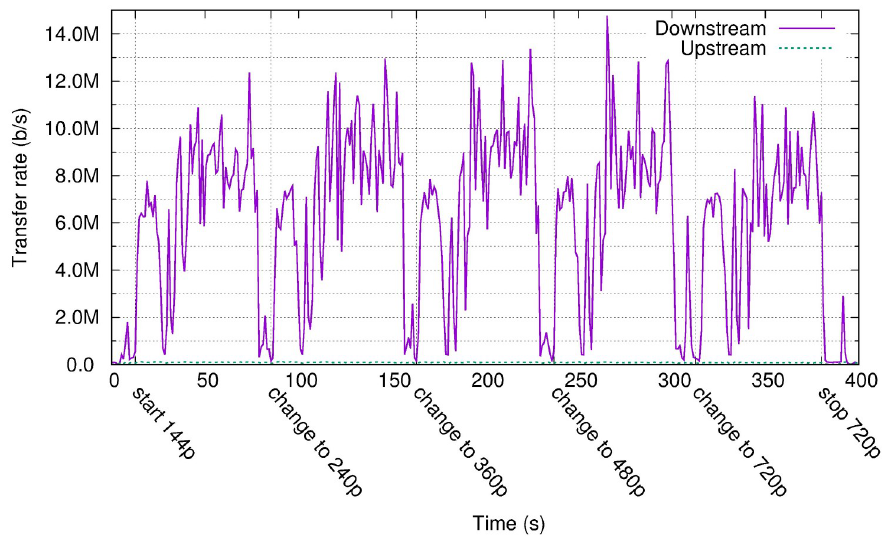
Fig 5. Transfer rate for video profile in Amazon WorkSpaces with full screen.